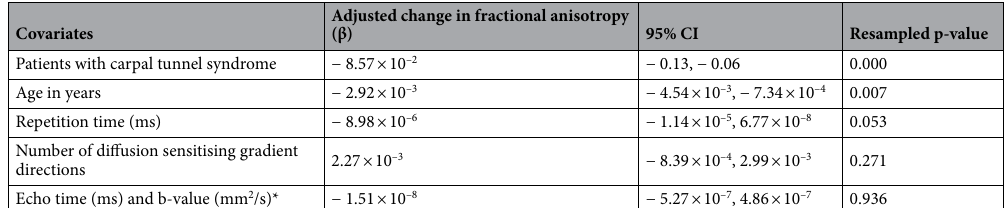
Table 1. Mixed-effects meta-regression. Adjusted R 2 = 46%, tau 2 = 0·0047, I 2 = 97%. *Echo time is a function of the b-value as larger b-values mandate relatively longer echo times, so these variables are modelled as the product to minimise the number of covariables, mitigate collinearity and model the interaction between the two